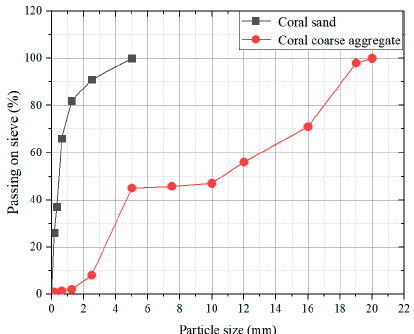
Figure 2. Size distributions of coral aggregates.